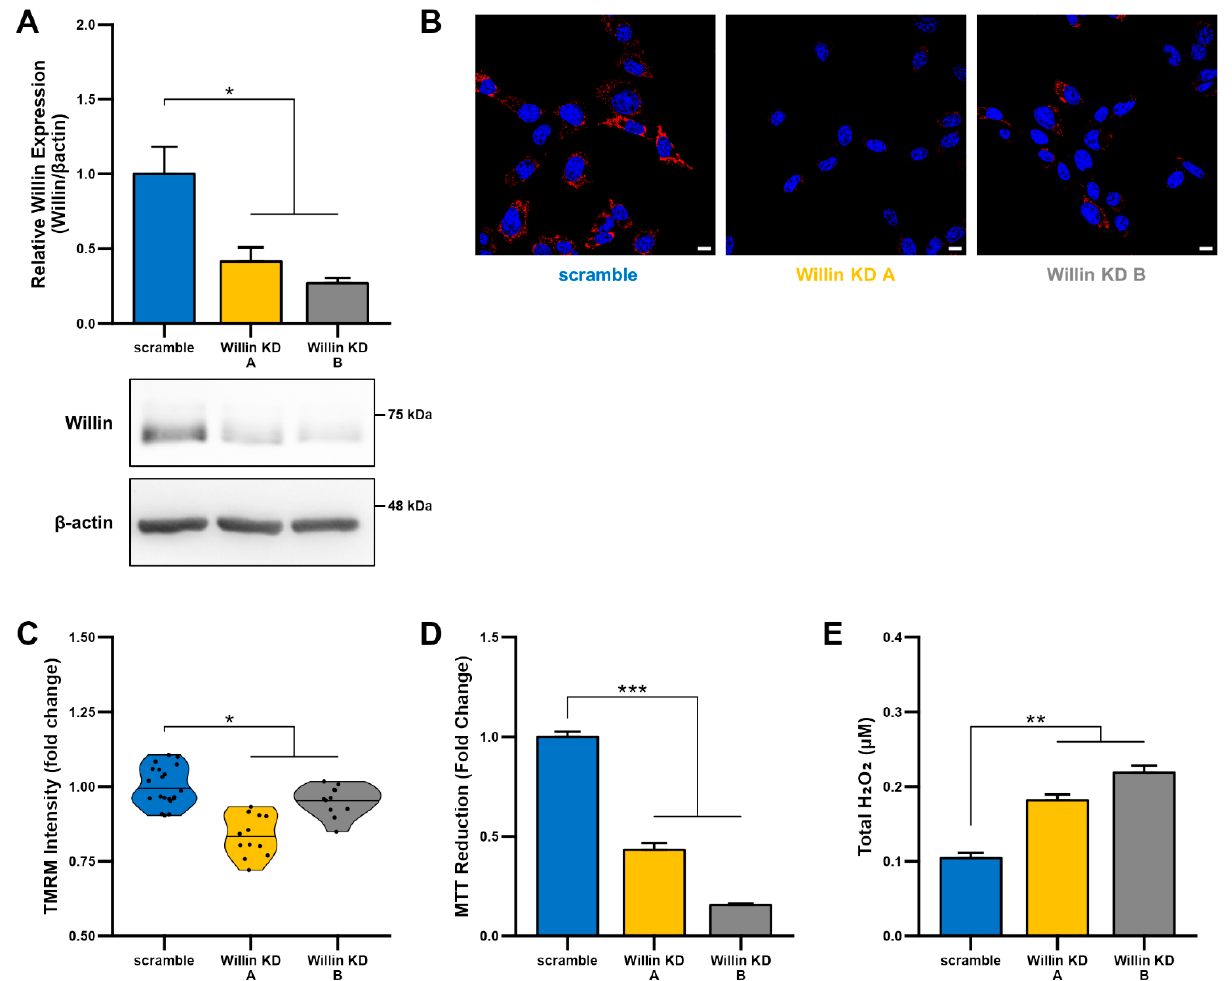
Figure 2. Downregulation of Willin/FRMD6 induces mitochondrial dysfunction in HT-22 cells. ( A ) Densitometry of Willin/FRMD6 immunoreactive bands in lysates from control (scramble) and Willin/FRMD6 knockdown (Willin KD A and Willin KD B) cells. β -actin served as a protein loading control. Upper panel represents quantification of immunoreactive bands relative to β -actin. Data are expressed as fold change relative to the control group. Representative immunoblots are shown underneath. n = 3 per group. * p < 0.05. ( B , C ) Mitochondrial membrane potential was measured by TMRM staining intensity. ( B ) Representative images of TMRM staining. Scale bar = 10 µ m. ( C ) Quantification of mitochondrial staining intensity for TMRM using MitoSegNet. n = 11–20 fields of view (FOV) per condition with 10–50 cells per FOV. Dots represent mean TMRM staining intensity per FOV. * p < 0.05. ( D ) Mitochondrial redox capacity measured by MTT reduction assay. n = 3 per group. *** p < 0.001. ( E ) Total ROS production determined by Amplex TM Red assay. n = 3 per group. ** p <